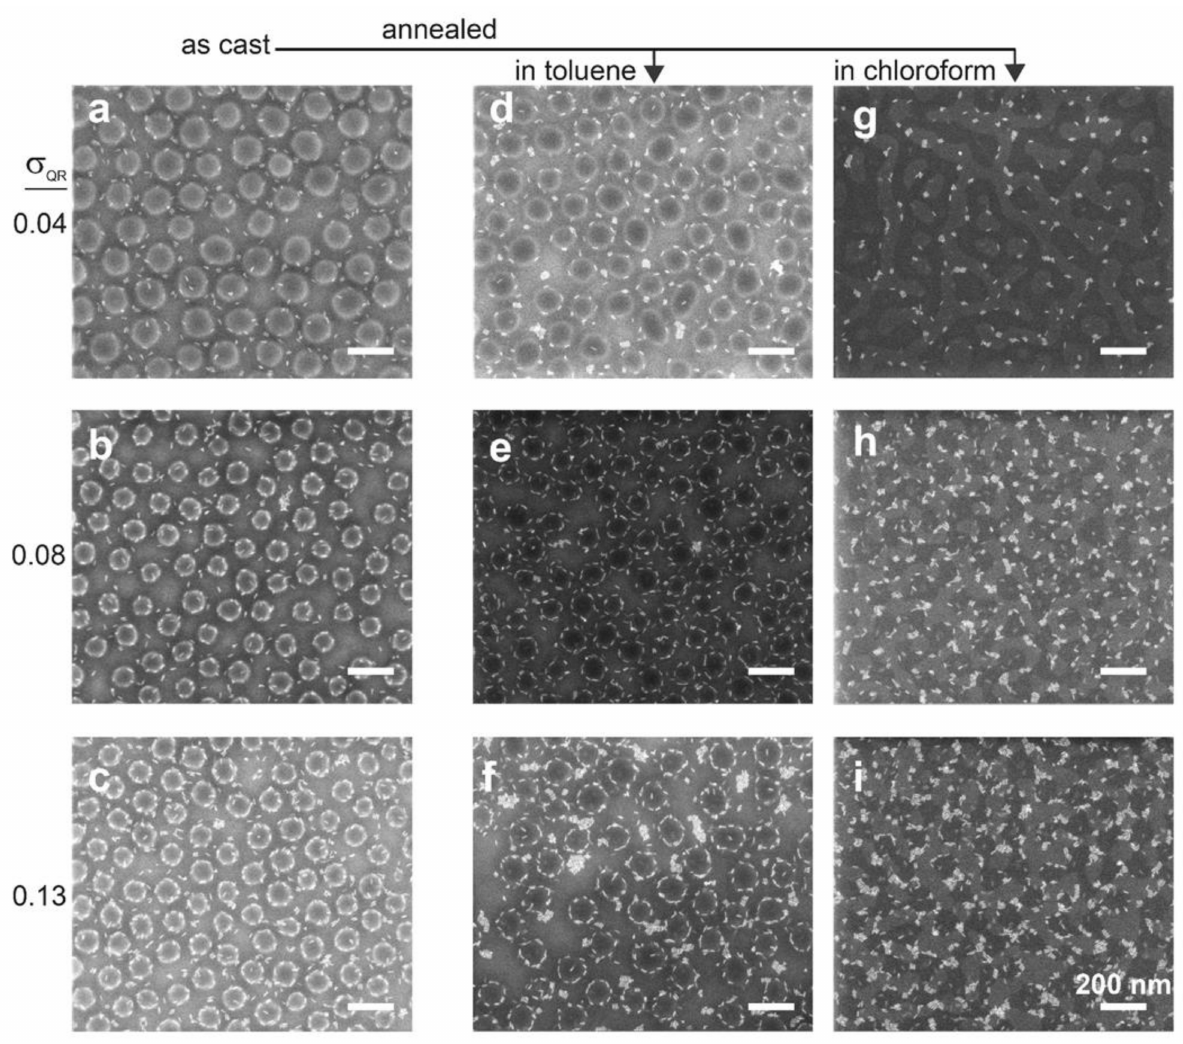
Figure 2. Effect of annealing solvent and QR filling fraction in 0.5 wt.% BCP-based nanocomposites cast from toluene solutions: ( a – c ) as-cast films; ( d – f ) films annealed in toluene vapor; ( g – i ) films annealed in chloroform vapor. The QR filling fractions are quantified as observed surface fraction ( σ QR ); see Section 2 for additional